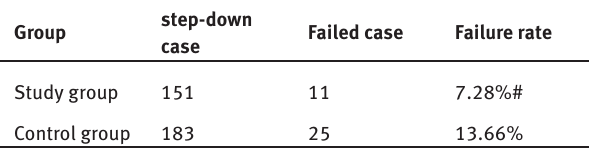
Table 3: Failure rate of step-down treatment between two groups. Group